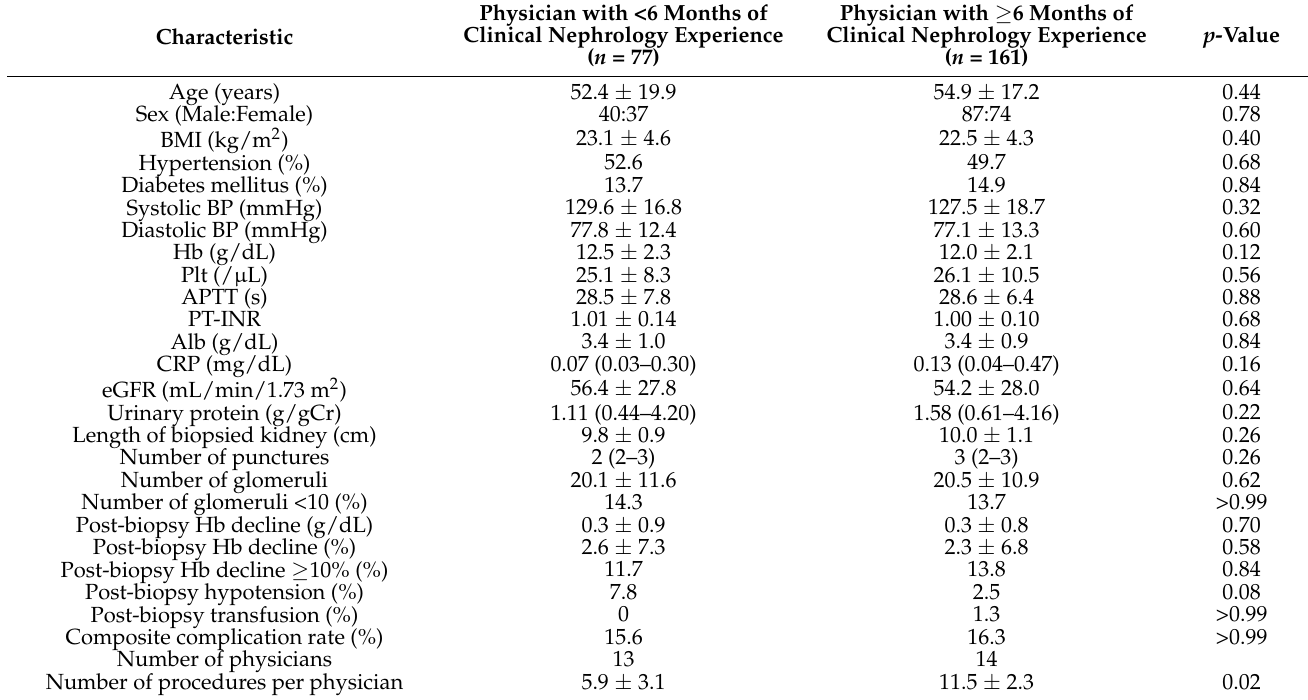
Table 3. Comparison of renal biopsies performed by physicians with <6 months and ≥ 6 months of clinical nephrology experience. Characteristic